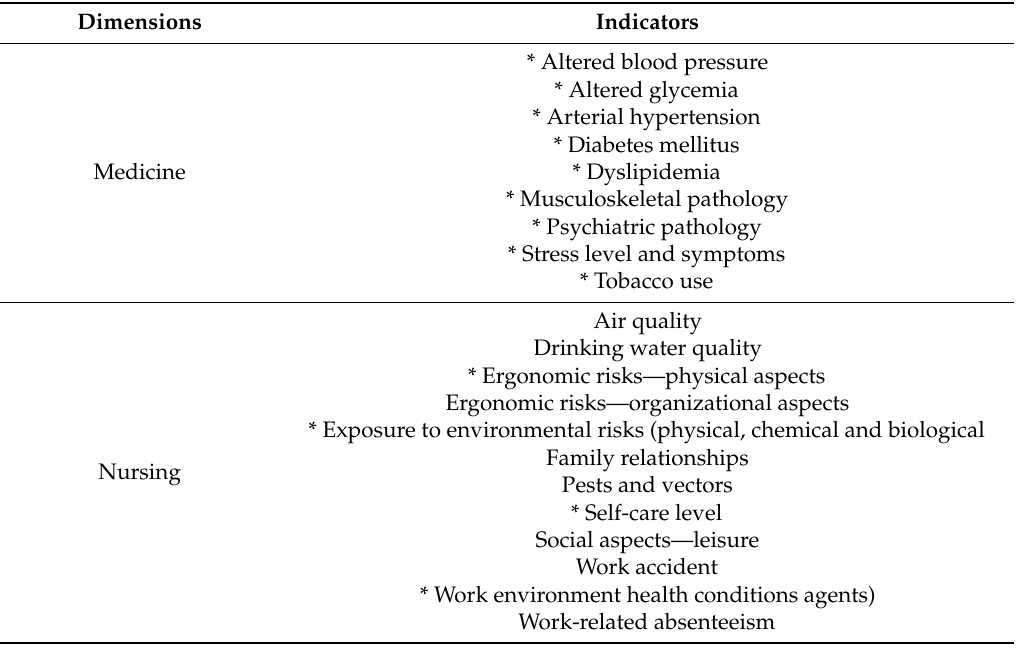
Table 2. IWHAI dimensions and